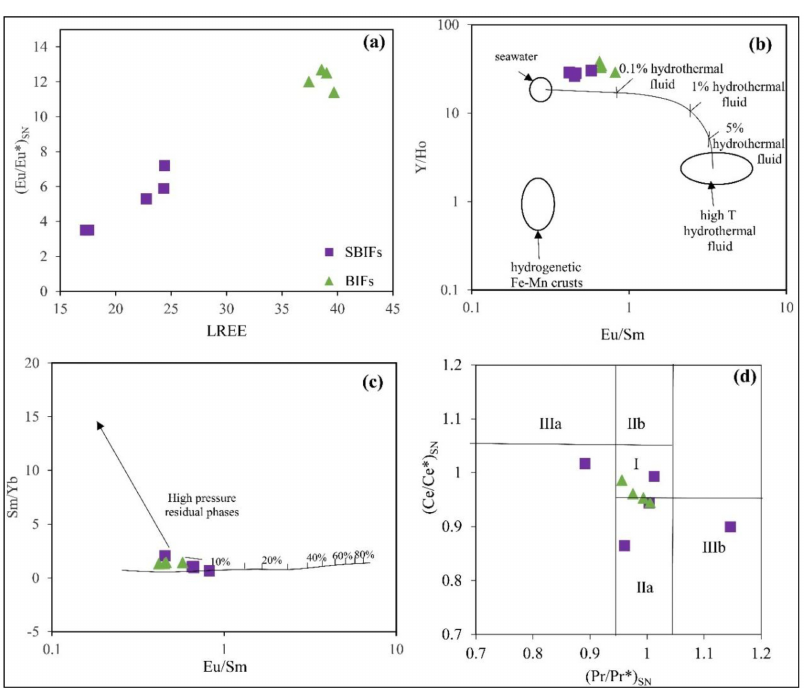
Figure 17. Contribution of seawater and hydrothermal fluids for the Anyouzok IFs precipitation: ( a ) (Eu/Eu*) SN vs. LREE diagram for the Anyouzok IFs; ( b ) Eu/Sm vs. Y/Ho [84] with a conser- vative mixing line of high-temperature hydrothermal fluid [92] and seawater [101]; ( c ) Eu/Sm vs. Sm/Yb plot [85] with a conservative mixing line of high-temperature hydrothermal fluid [8] and seawater [101]; ( d ) (Ce/Ce*) SN vs. (Pr/Pr*) SN plot [54] for the Anyouzok IFs. I: neither Ce nor La anomaly; IIa: positive La anomaly, no Ce anomaly; IIb: negative La anomaly, no Ce anomaly; IIIa: positive Ce anomaly; IIIb: negative Ce